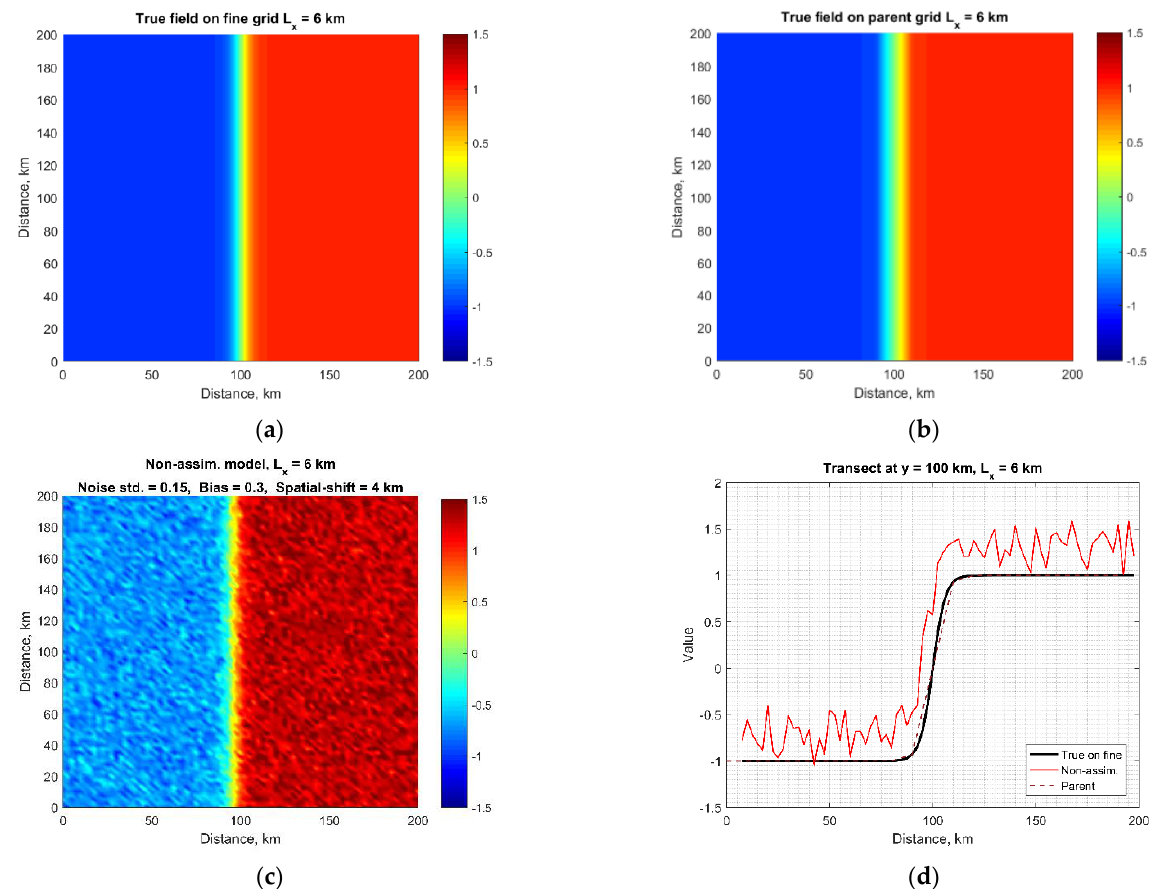
Figure 2. Ocean front of width 𝐿 𝑥 = 6 km. ( a ) True field on the fine mesh, ( b ) parent model ouput, ( c ) simulated child model before data assimilation, ( d ) transects of the previous fields along the line at 𝑦 = 100 km.